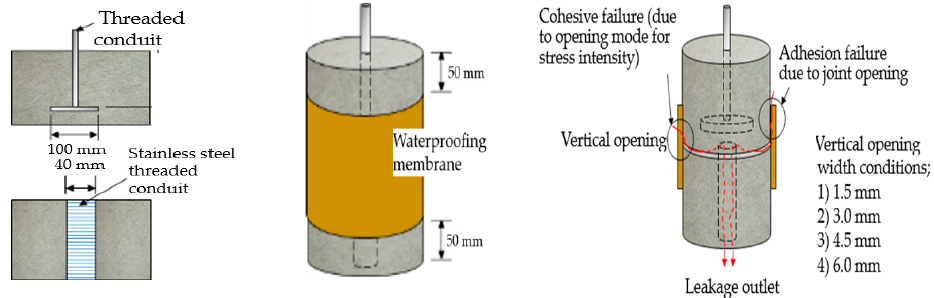
Figure 3. Movement simulation specimen for strain concentration ratio evaluation.